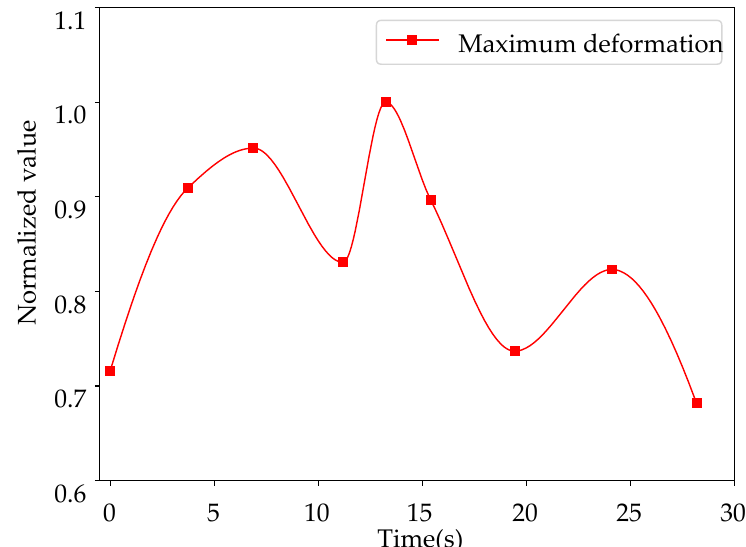
Figure 15. The maximum deformation of the head-cover during load rejection. In order to facilitate production processing, transportation and installation, the head- cover is usually manufactured as two symmetrical halves, which are assembled into a single structure during the installation in the power plant. As can be seen from Figure 16, the flow-induced deformation of the head-cover is also symmetrical. Since the connecting flanges of the head-cover are thicker than the stiffener plates, the deformation of the head- cover inner plate near the connecting flanges is smaller than the deformation of the inner plate at other locations. Therefore, increasing the thickness of the stiffener plates inside the head-cover can increase the local stiffness and effectively reduce the deformation of the inner plate of the head-cover.